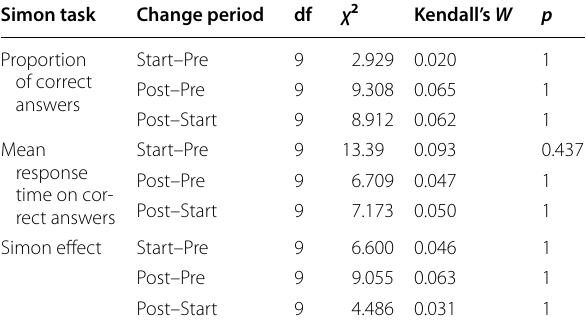
Table 5 Changes in Simon task